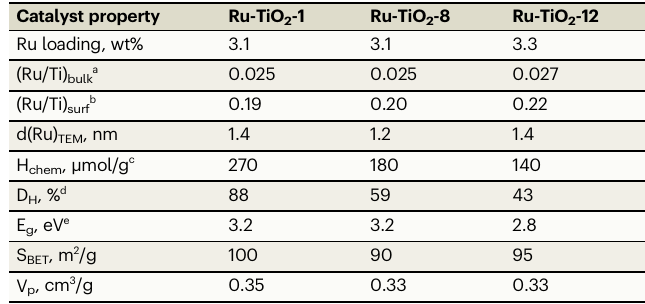
Table 1 | Ru/TiO 2 catalyst characterization Catalyst